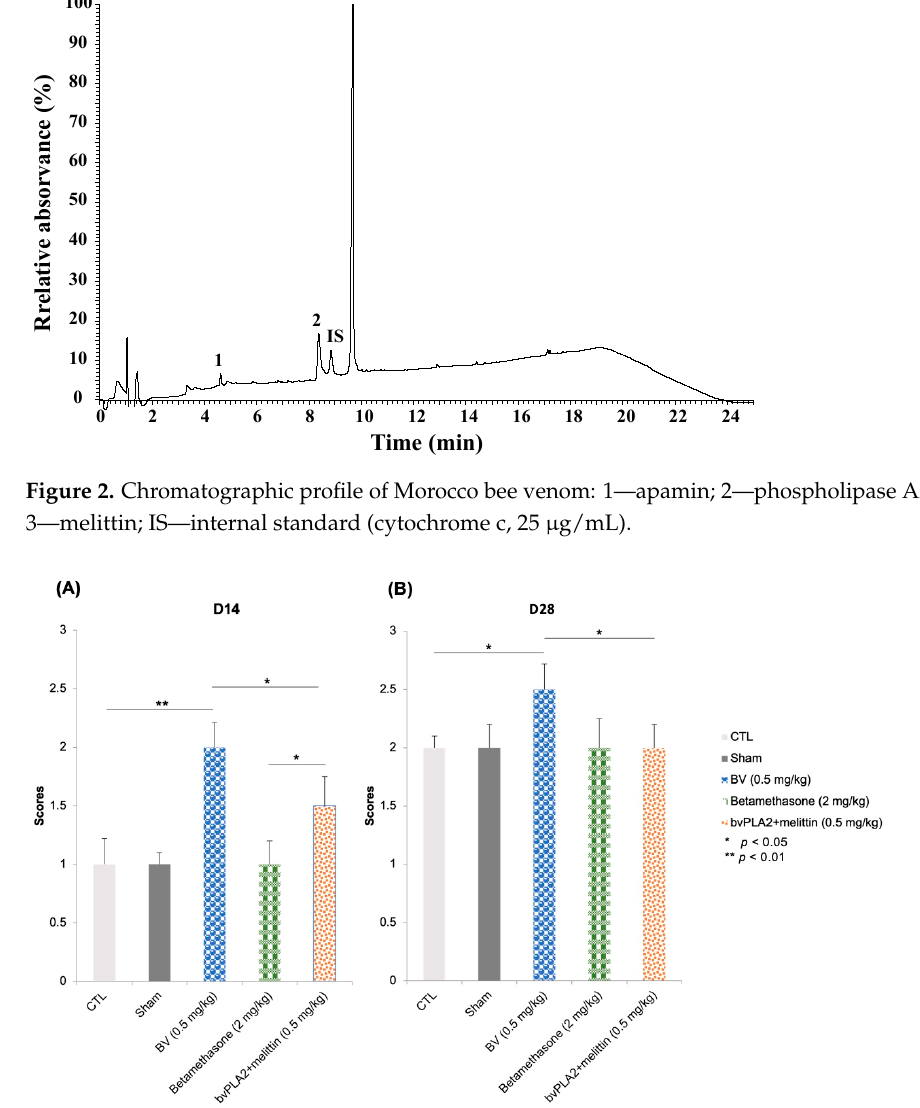
Figure 3. Graphical view of the mean and the standard deviation of the functional analysis (whisker movement). ( A ) Whisker movement 14 days after distal section-suture of the buccal and marginal mandibular branches of the facial nerve in different groups: control (injured mice without treat- ment), sham (saline 0.9%), BV (0.5 mg/kg of bee venom), betamethasone (2 mg/kg of Celestene), bvPLA2 + melittin (0.5 mg/kg of a mixture of bvPLA2 and melittin). ( B ) Whisker movement 28 days after distal section-suture of the buccal and marginal mandibular branches of the facial nerve in the same groups: control, sham (0.5 mg/kg of saline), BV (0.5 mg/kg of bee venom), betamethasone (2 mg/kg of Celestene), bvPLA2 + melittin (0.5 mg/kg of a mixture of bvPLA2 and melittin). The data were tested by one-way ANOVA followed by t